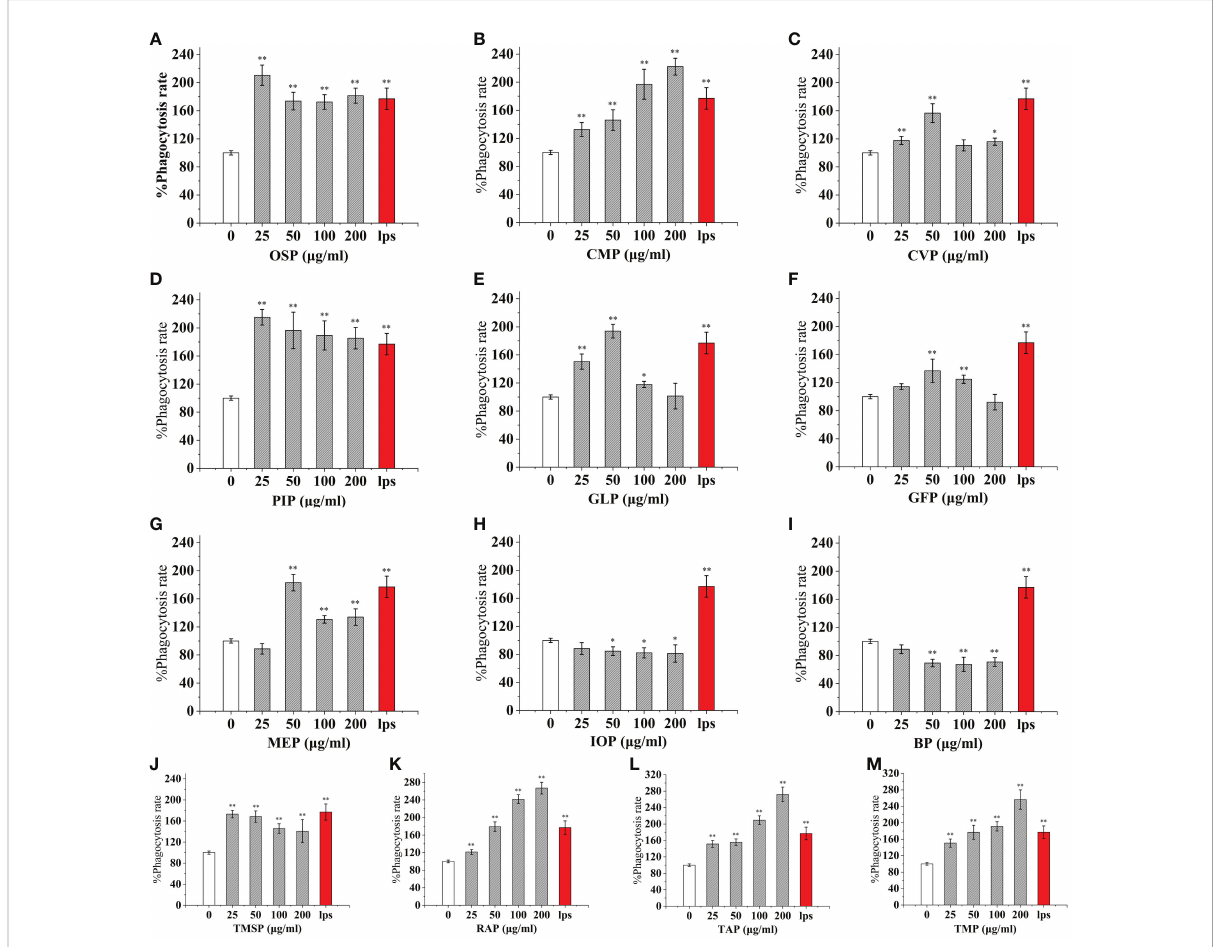
FIGURE 3 Phagocytosis of thirteen rare edible mushroom proteins on RAW 264.7 cells. OSP (A) , CMP (B) , CVP (C) , PIP (D) , GLP (E) , GFP (F) , MEP (G) , IOP (H) , BP (I) , TMSP (J) , RAP (K) , TAP (L) , and TMP (M) on the phagocytosis of RAW 264.7 cells. Data are expressed as mean ± SD (n = 5). *P < 0.05, **P < 0.01, compared with the control